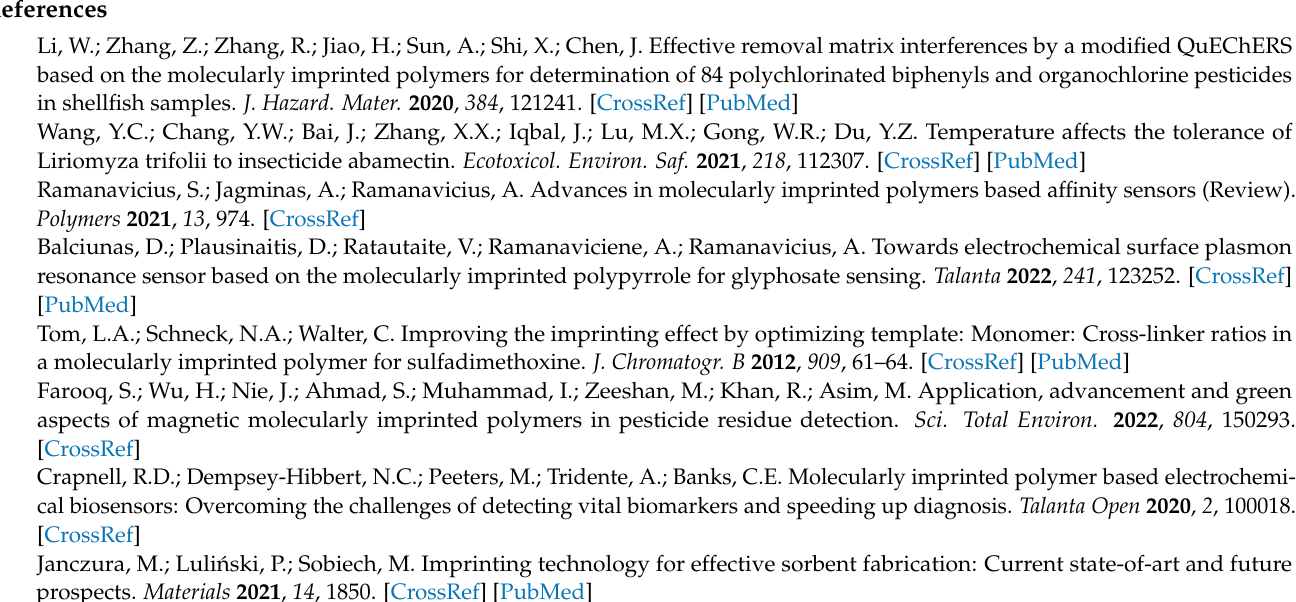
Linear fitted plots of Ce/qe versus Ce for Langmuir, Figure S3: Linear fitted plots of log q versus log Ce for Freundlich, Figure S4: HPLC-UV chromatograph for abamectin, eprinomectin and acetamiprid, Table S1: Details of polymerization